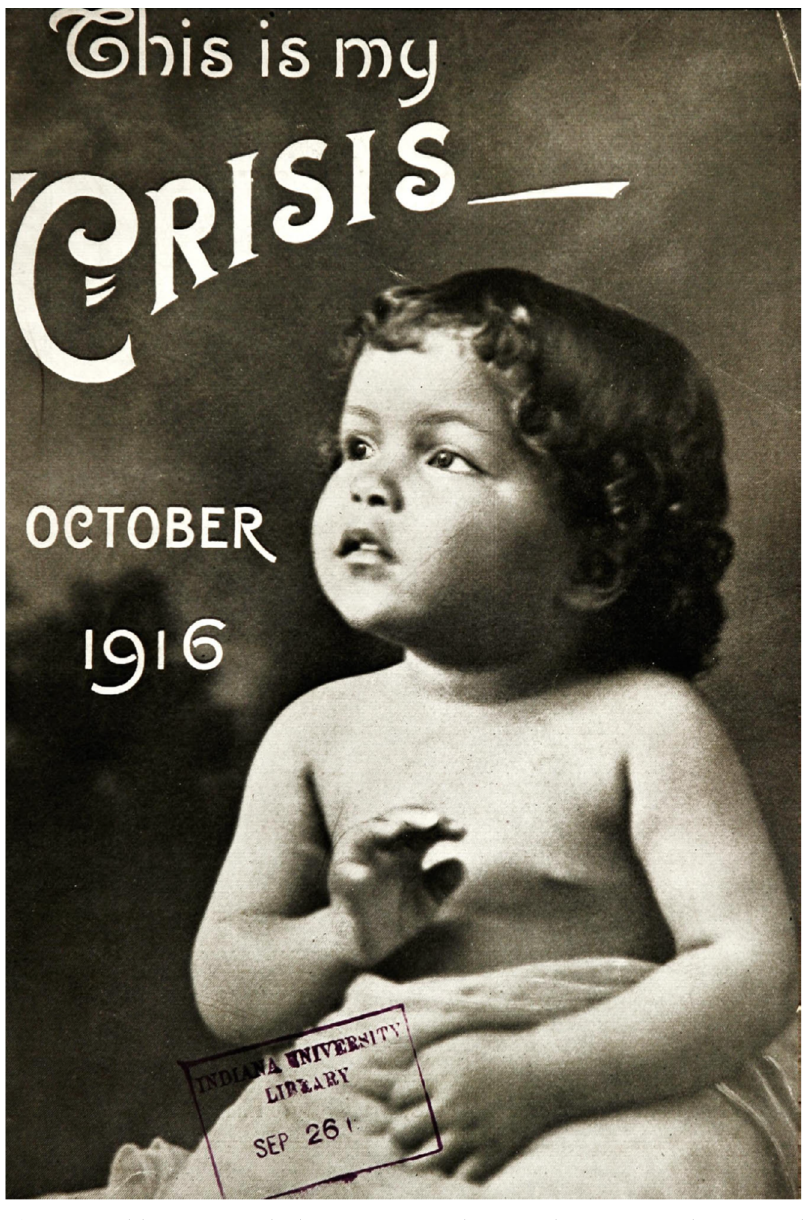
Figure 7. Addison N. Scurlock (1916), cover photograph, Crisis , October 1916. The Modernist Jour- nals Project, https://modjourn.org/issue/bdr510140/, (accessed on 4 December 2018).